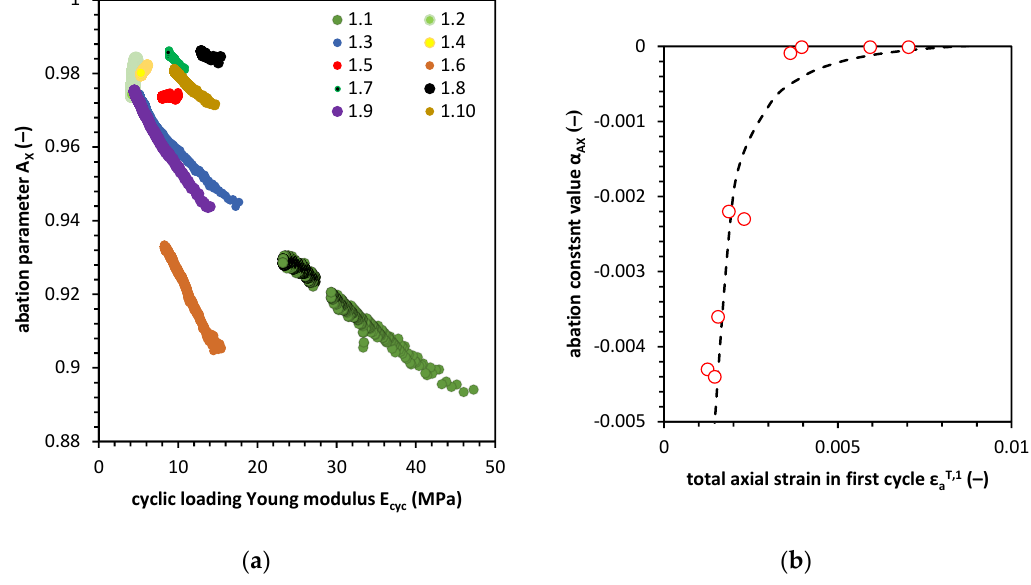
Figure 12. The abation parameter characteristics: (a) the abation parameter A x relationship to cyclic Young modulus E cyc ( b ) and the relation between the abation constant and total strain in the first cycle of loading ( b ).